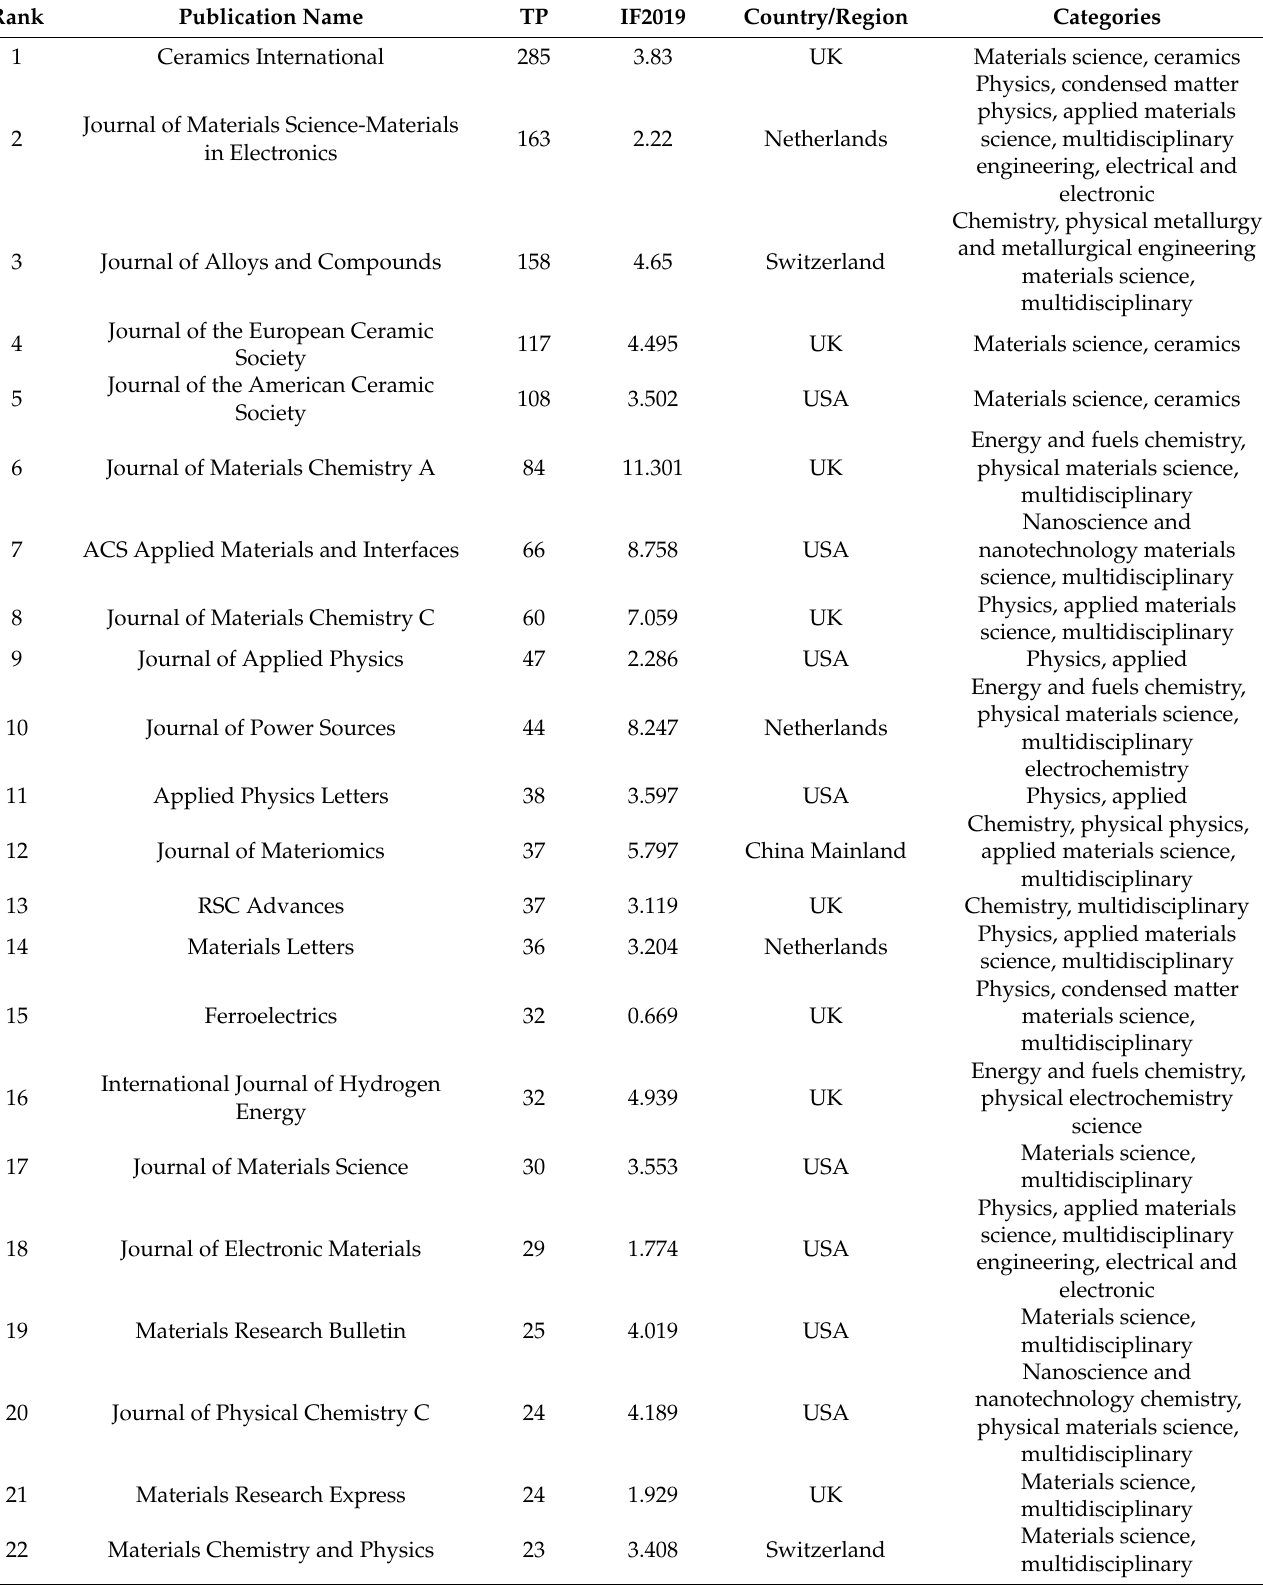
Table 4. Contribution of the top 30 most productive publications in energy storage ceramics